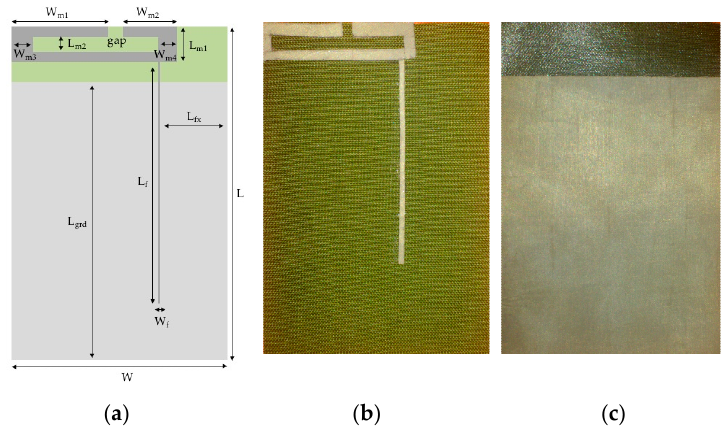
Figure 1. Textile antenna. ( a ) Design of the dual-band antenna; ( b ) Front; and ( c ) Back. Table 1. Dimensions of the textile antenna.